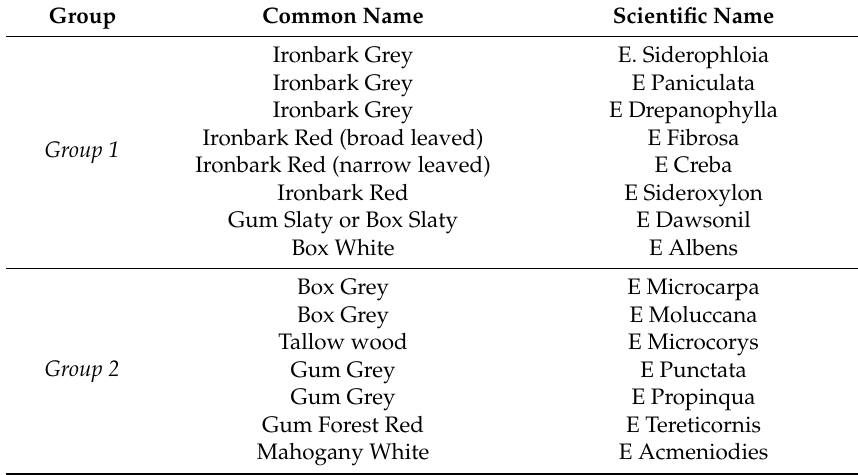
Table 1. Timber species for railway turnout applications [3].